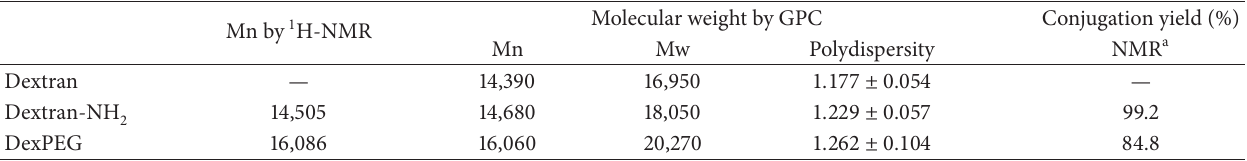
Table 1: Characterization of the DexPEG block copolymer.